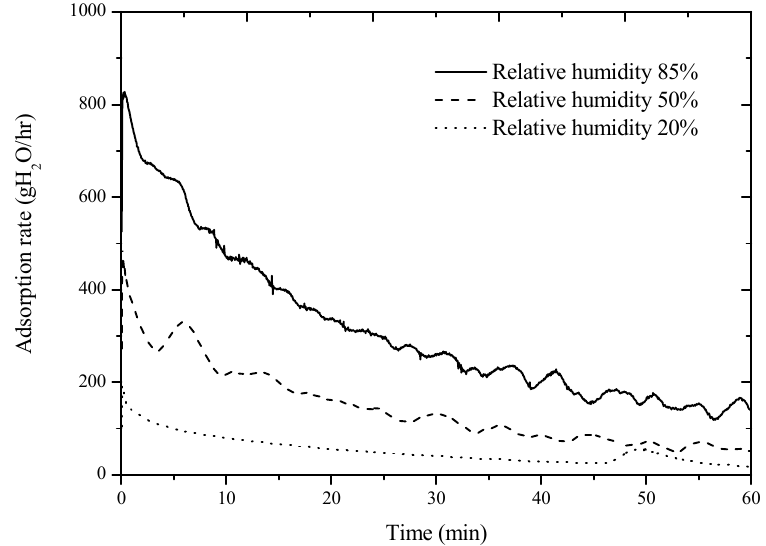
Figure 4. The variation of adsorption rate of the desiccant device with time at an ambient temperature of 15 °C and an airflow rate of 90 m 3 /h at various relative humidity levels of air.